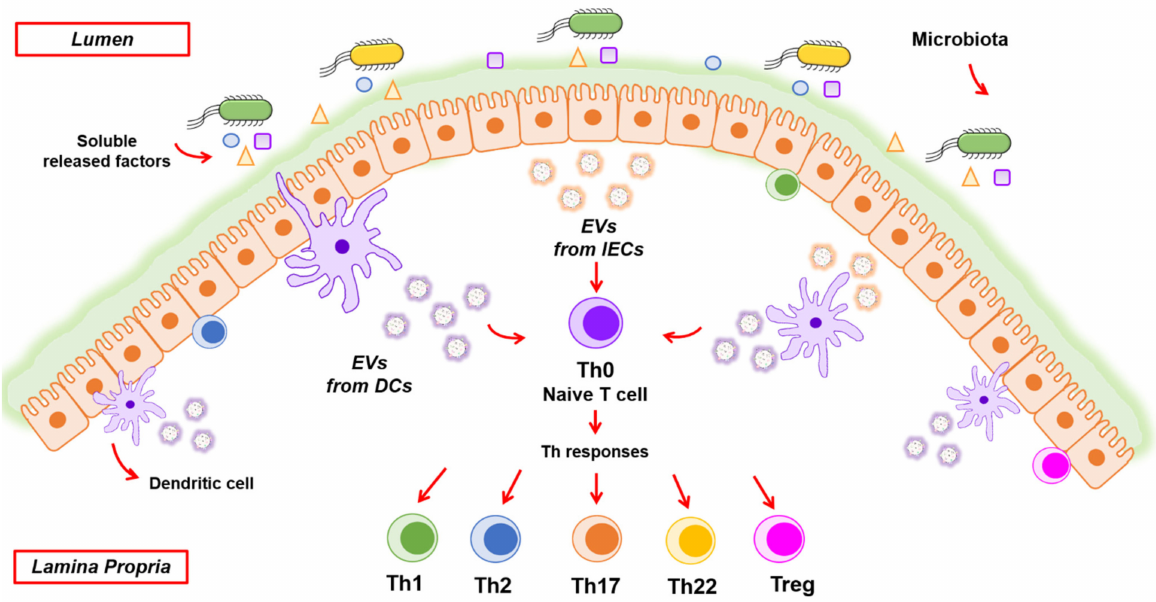
Figure 2. Modulation of immune responses by EVs originated from intestinal epithelial and immune cells. Schematic view of the intestinal mucosa showing the epithelium and the underlying immune system. These host cells receive information from microbiota mainly through secreted factors and lumen antigens that can diffuse through the mucus layer and initiate appropriate immune responses. In this scenario, EVs are key for the host to communicate with neighboring cells. Intestinal epithelial cells (IECs) release EVs from the basolateral side (colored in brown) that participate in the crosstalk with lymphocytes and dendritic cells, being able to activate naïve T cells towards immunogenic (Th) or tolerogenic (Treg) responses depending on the exosome-expressed epitopes and cargo. DCs are the main antigen-presenting cells in the gut lamina propria. These immune cells can integrate information either directly from the intestinal lumen or transmitted through EVs secreted by other cell types under healthy and pathological conditions (intestinal infections, inflammation, or cancer). Once activated, DCs secrete EVs (colored in purple) containing MHC and costimulatory molecules that mediate antigen presentation and immunomodulatory effects towards CD4+ or CD8+ T cells, eliciting suitable T cell